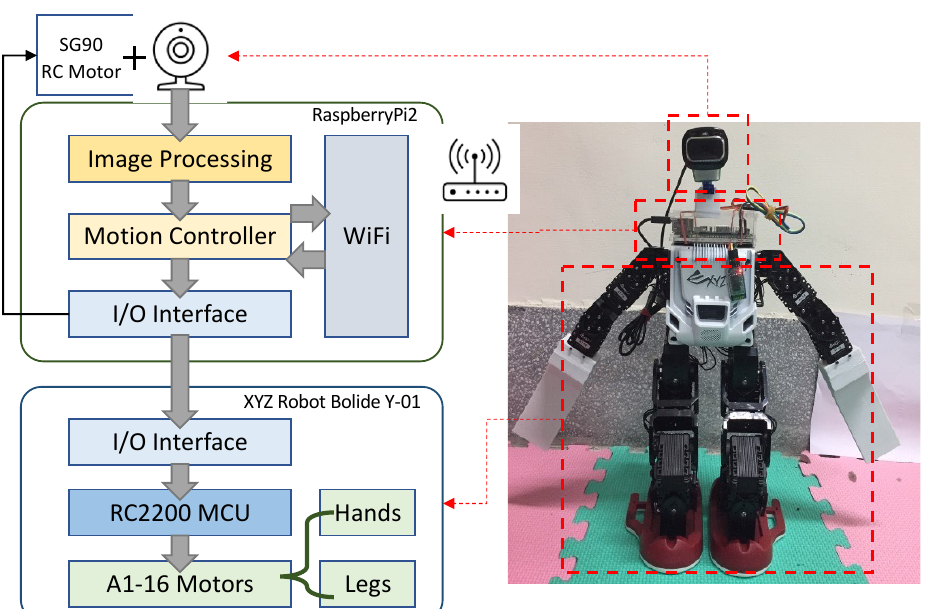
Figure 1. The diagram of the cooperation transportation system.